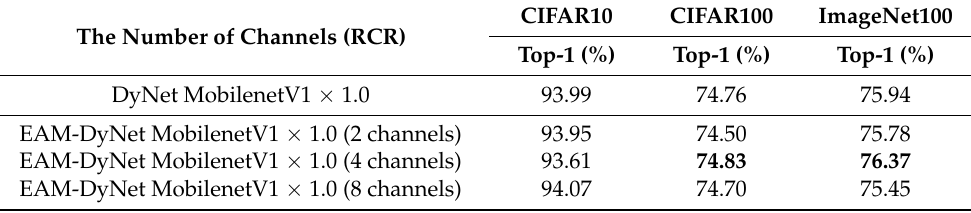
Table 3. The accuracy of standard static network, standard dynamic network, and EAM-DyNet when using the Random Channel Reduction (RCR) method to take out channels of different sizes on MobilenetV1.